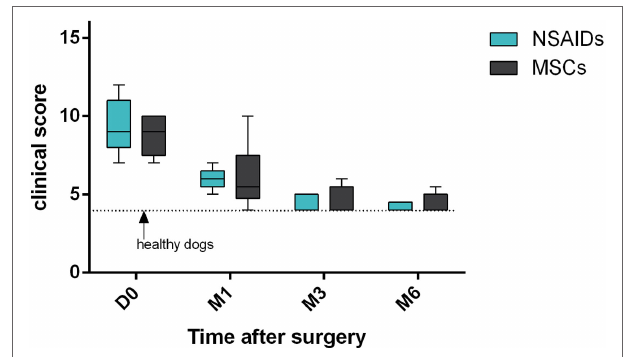
FiGUrE 1 | Clinical scores’ comparison between “mesenchymal stromal cells (MSCs)” group and “non-steroidal anti-inflammatory drugs (NSAIDs)” group. No significant difference was observed. Larger distribution was observed in the “MSCs” group.